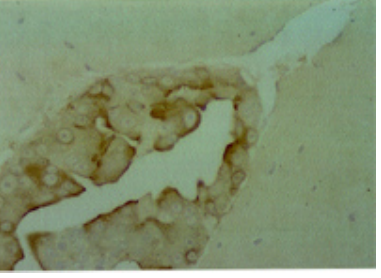
FIGURE 2 . The tumor is positive with antibodies to Prostatic Specific Antigen (PSA). x400 Immunoperoxidase